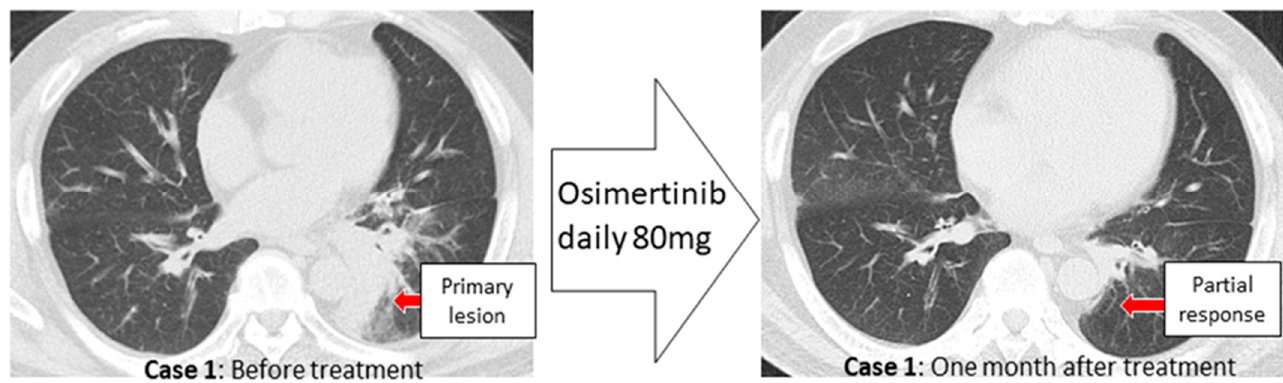
Figure 4. Cases 1 showed a favorable response after administration of molecular-targeted drugs.